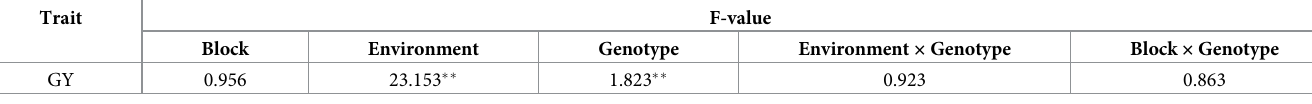
Results of population structure analysis were shown in Tables 3 and 4. K value and Δ K were evaluated (Fig 1A). The peak value of Δ K was observed when K = 5. Therefore, an ideal struc- ture of the research population was divided into 5 subpopulations, namely Lancaster, PB, Tang SPT, Reid and Lvda Red Cob (LRC) (Table 4, Fig 1B). Accordingly, the structure of the research population was not complex and was satisfactory for applying the population struc- ture analysis.